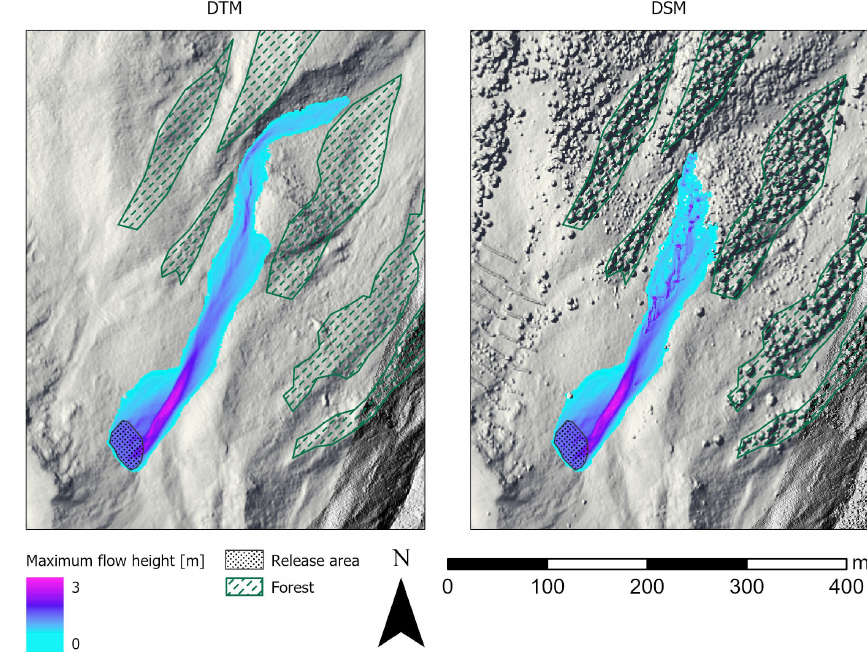
Figure 8. Avalanche simulation output (maximum flow height) in the Braema study area. The avalanche runout distance was 112m greater when the DTM was used as the input model for the simulation than when the DSM was used (visualised are the hillshades calculated from the terrain and surface model swissALTI3D; © swisstopo, 2018). The maximum flow height was 0.4m greater when the DSM was used, as a result of the interaction with the roughness